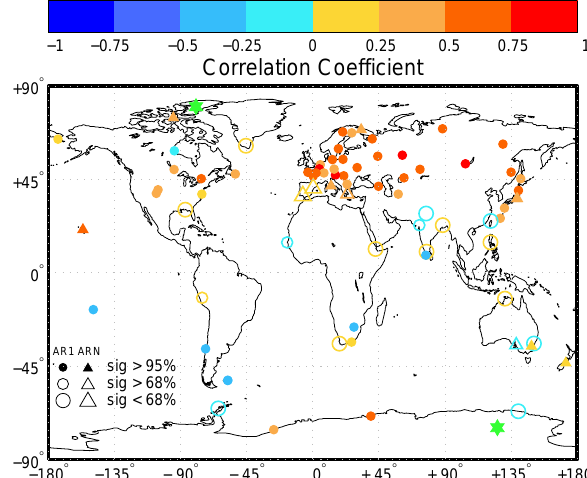
Figure 2. Correlation coefficients for log power ratios of semi- annual to annual variability in fo F2 for each station compared with Slough/Chilton. Each correlation is represented by a symbol plot- ted at the location of the ionospheric monitoring station. Positive correlations are shown in colours ranging from yellow to red while negative correlations in are shown as shades of blue. Correlations exceeding 95% significance are represented by filled symbols; cor- relations that are less significant than this are represented by open circles according to the scale shown. Circles represent correlations for which only the first lag of the autocorrelation function needed to be accounted for; triangles represent correlations where more than one lag needed to be accounted for. The positions of the geomag- netic poles are indicated by green